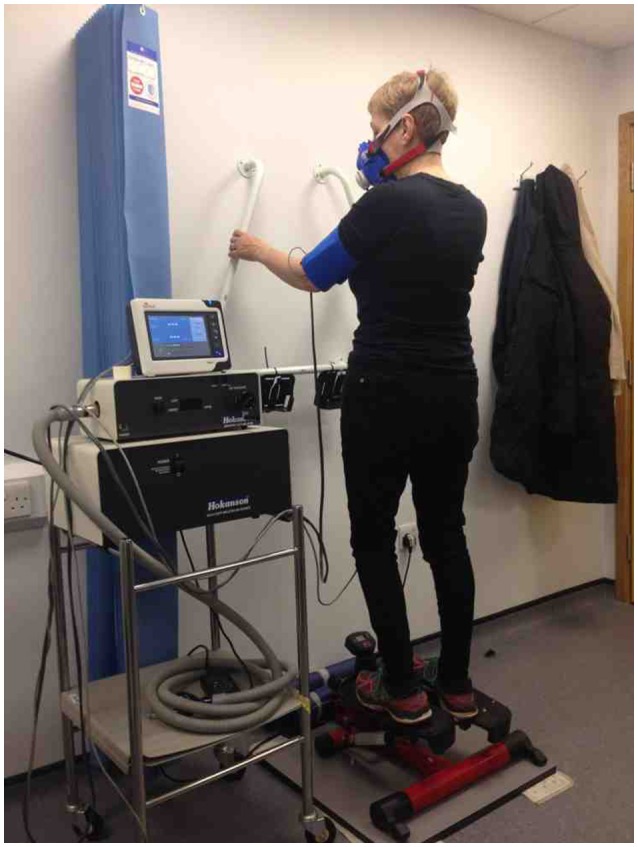
Example set-up for the 6-min stepper test including blood pressure monitor and gas analysis mask.